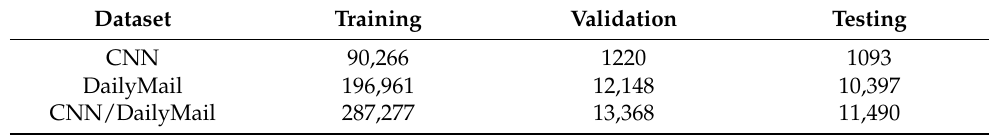
Table 1. Benchmark datasets (CNN, DailyMail, and